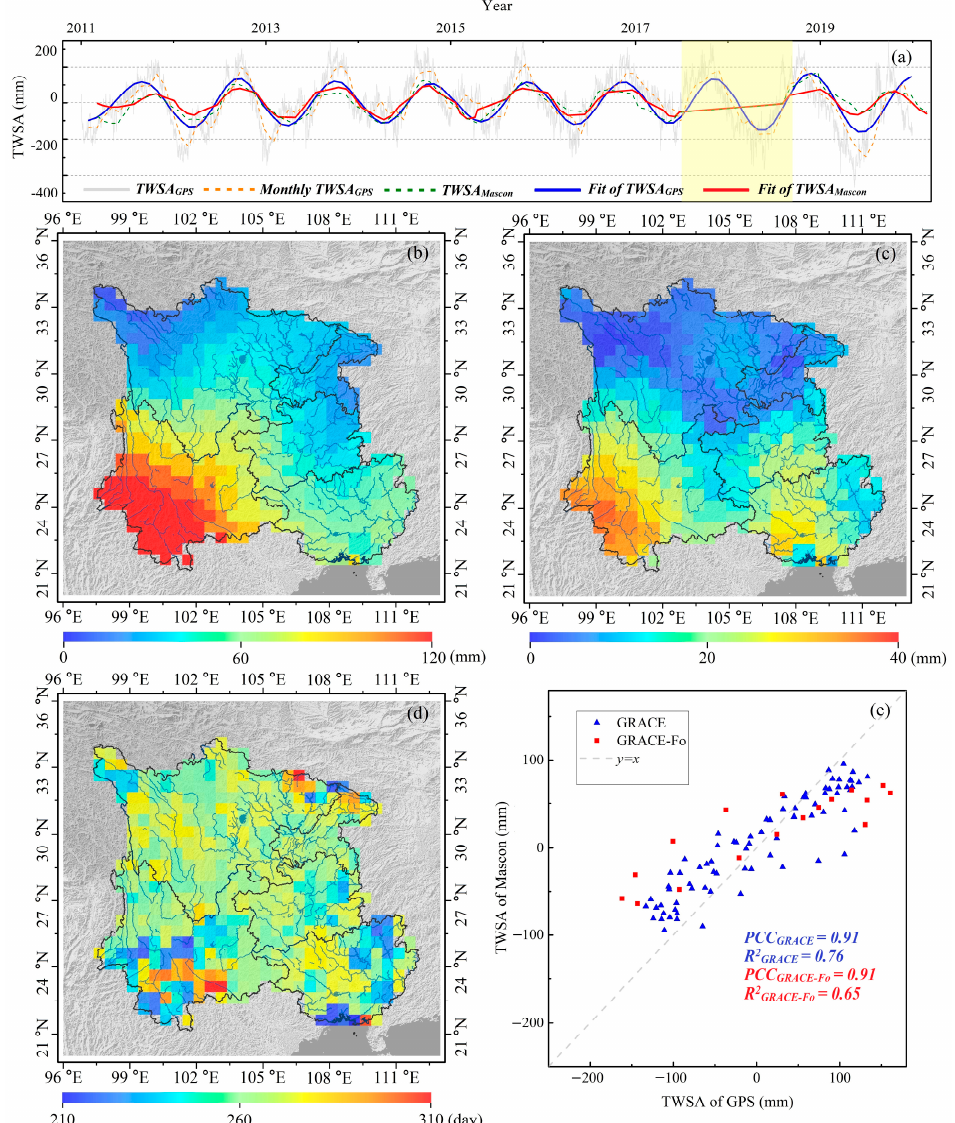
Figure 9. The compared result of GRACE, showing in the average fitting sequence ( a ), annual ( b ), semi-annual ( c ) and periodic items ( d ) of GRACE, and scatter figure ( e ).